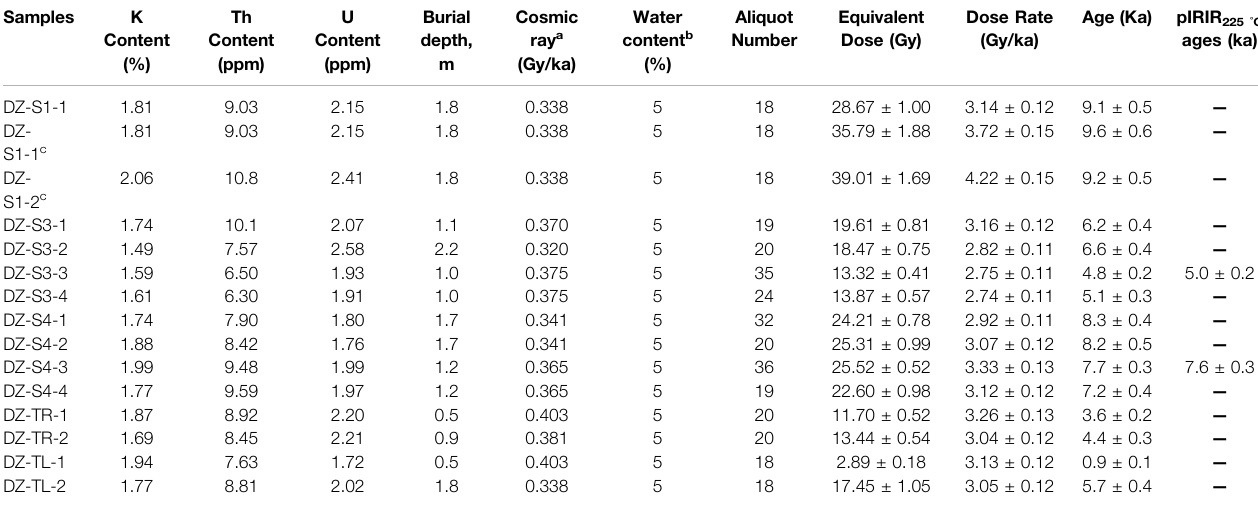
a The error for the cosmic rays dose rate is estimated at ±0.02 Gy/ka. b The error for the water content is estimated at